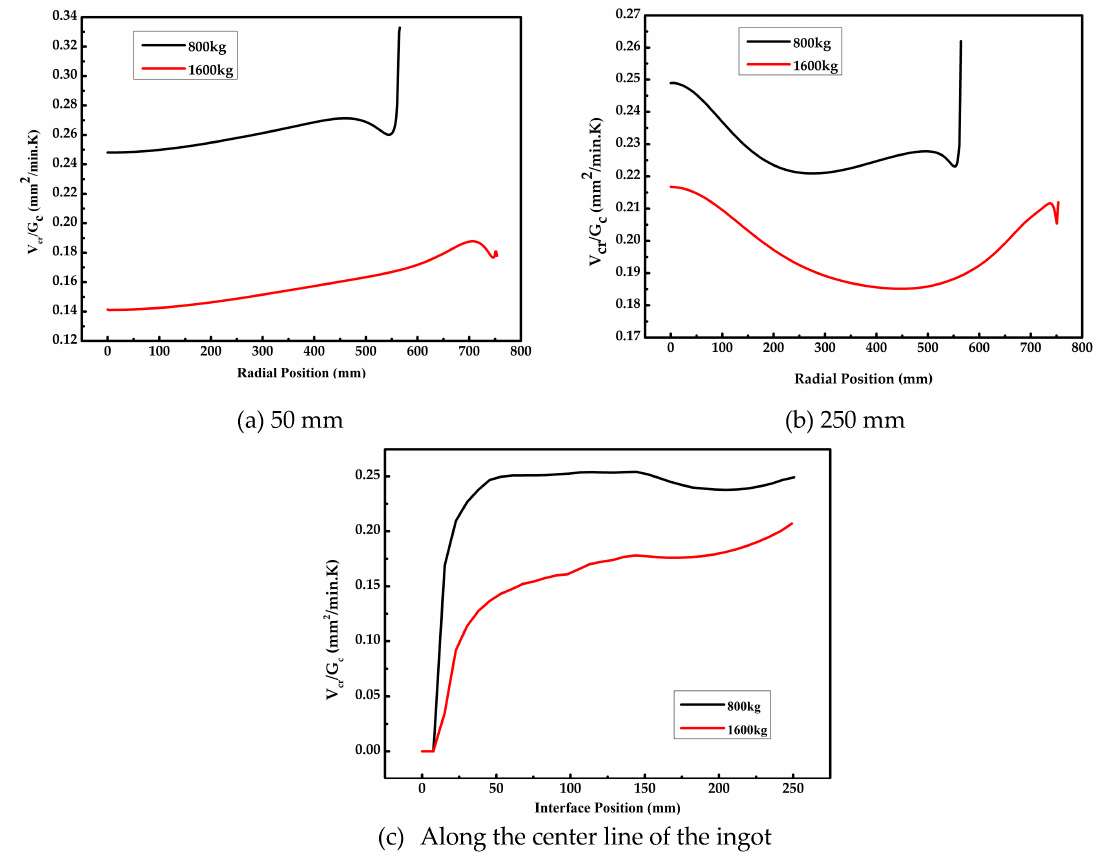
Figure 5. Comparison of V cr /G c in the radial direction at crystal heights of 50 mm ( a ) and 250 mm ( b ), and in the vertical direction along the center line of the ingot ( c ).